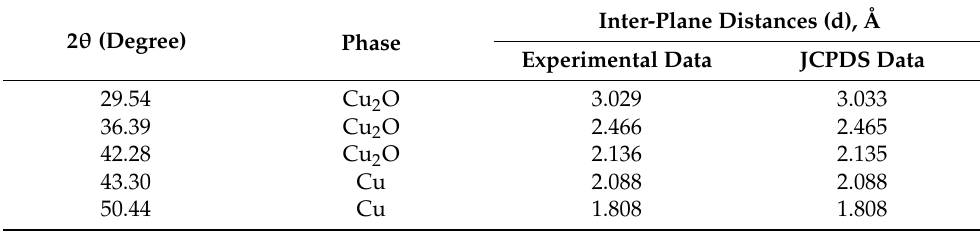
Figure 3. X-ray diffraction patterns of copper-containing particles obtained using solutions of various compositions. Peaks were identified and assigned as follows: cubic cuprite Cu 2 O (5–667) and cubic copper Cu (4–836). Table 3. Comparison of experimentally determined inter-plane distances with JCPDS data. 2 θ (Degree)